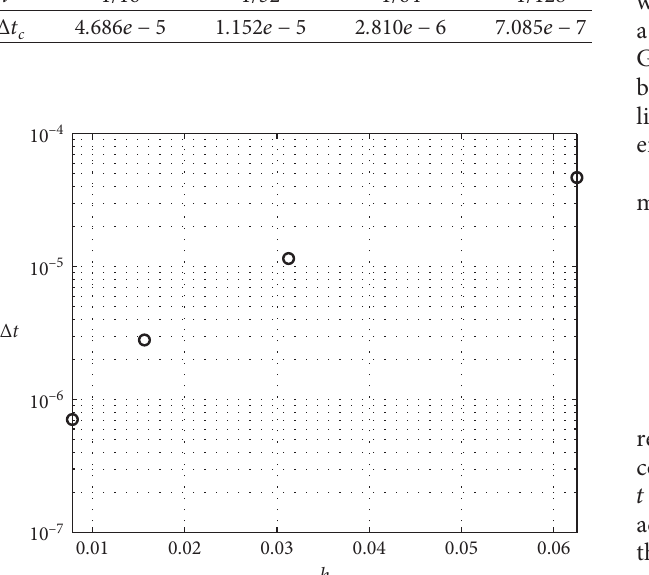
Figure 1: Practical maximum time step size Δ t h . c with respect to Figure 2 represents the CPU times (seconds) with respect to the number of spatial step N x , performed on Intel Core i5-6400 CPU at 2.70 GHz with 4 GB RAM. When we vary N x as 16, 32, 64, and 128 with fixed parameters, Δ t � ( 1/128 ) 4 and N t � 10 7 , the CPU times are 88.812, 175.468, 354.14, and 708.718. That is, when N x is doubled, the CPU time is approximately doubled.